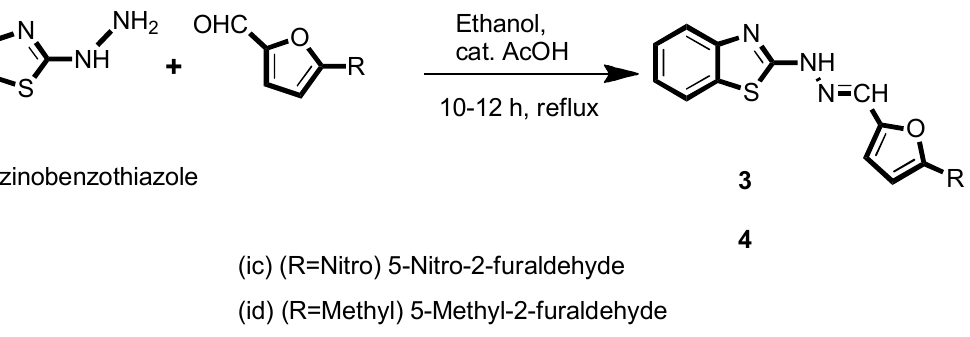
Figure 2. The structures of benzothiazole derivatives.